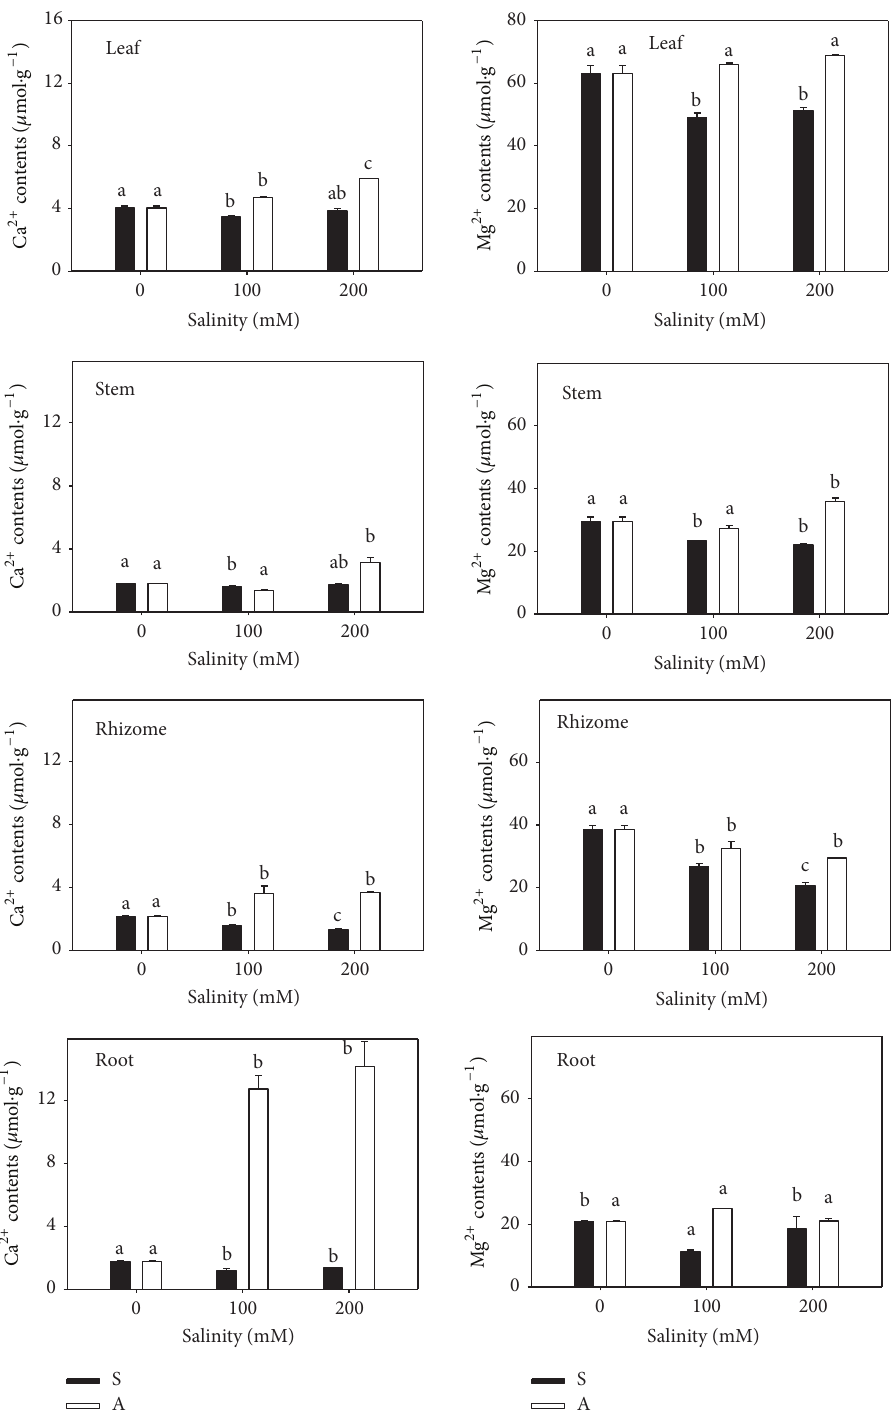
Figure 3: The Ca 2+ and Mg 2+ contents. The effects of salt stress (S) and alkali stress (A) on the Ca 2+ and Mg 2+ contents in rhizomes, stems, roots,andleavesof L.chinensis .Therearethreelevelsunderbothstresses:0,100,and200 mmol/L.Themeansandstandarderrorsarereported. Within each column, the different letters indicate significant difference among treatments ( 𝑃 < 0.05